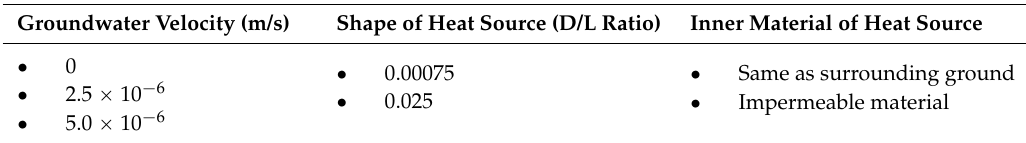
Table 1. Conditions of each numerical analysis case.